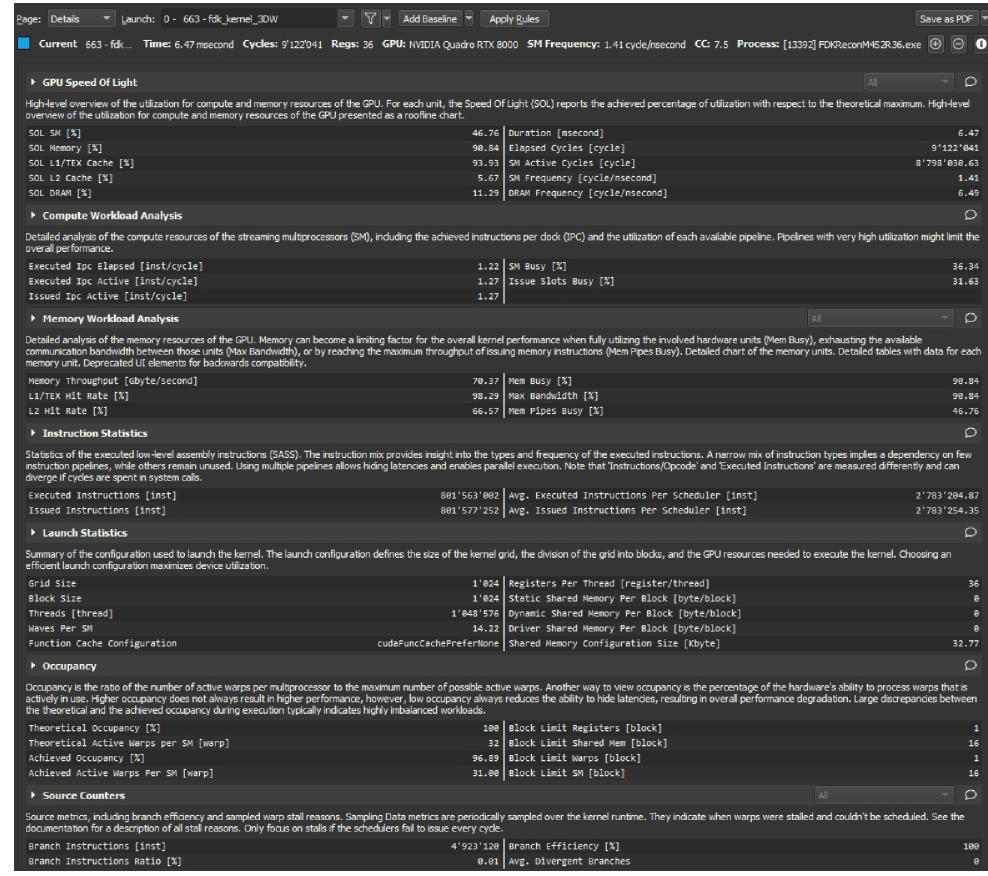
Figure A1. Backprojection kernel profiling using Nsight Compute on Nvidia Quadro RTX